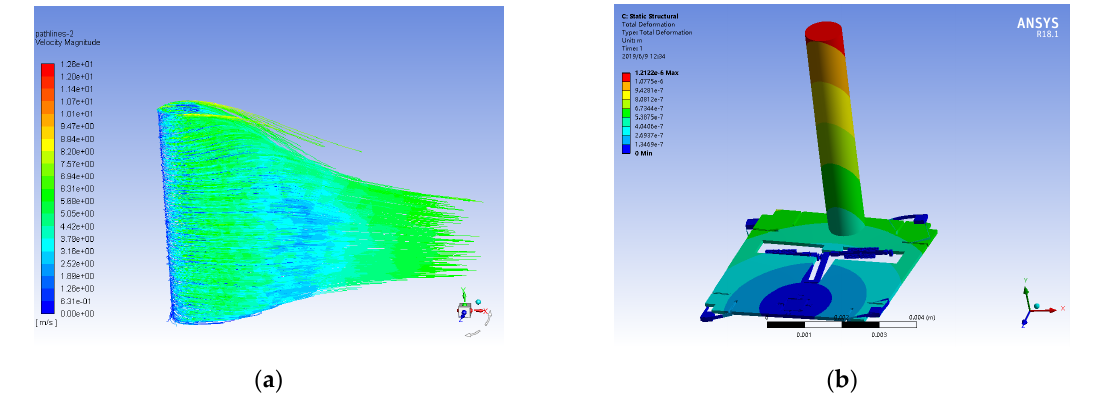
Figure 5. Flow velocity simulation of 10 m / s in a superficial neuromast flow velocity sensor. ( a ) Fluid velocity path-line of the hair surface; ( b ) Displacement simulation of the hair sensor.